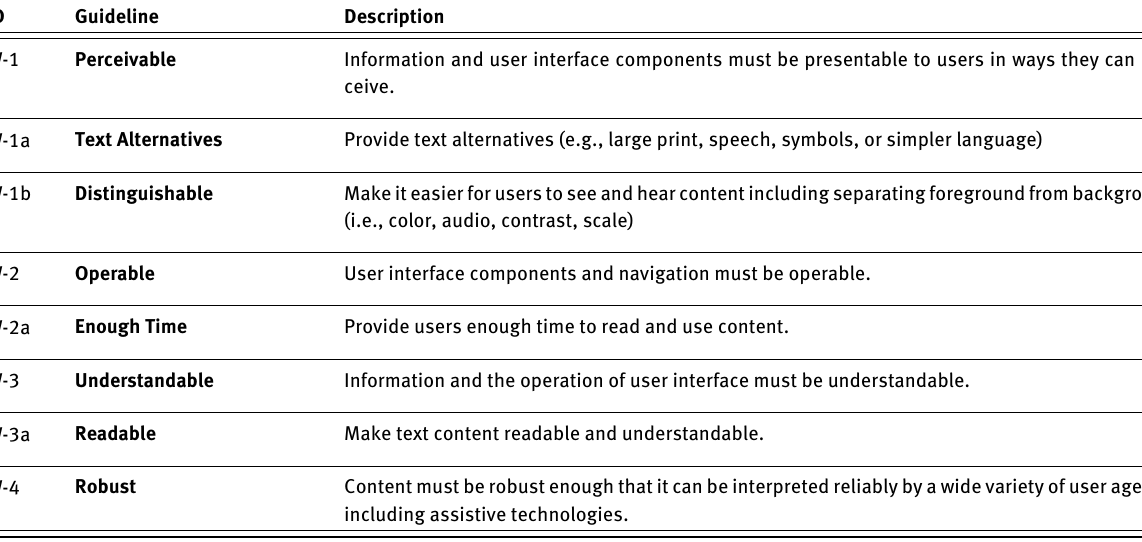
Table 10. Relevant W3C Web Content Accessibility Guidelines